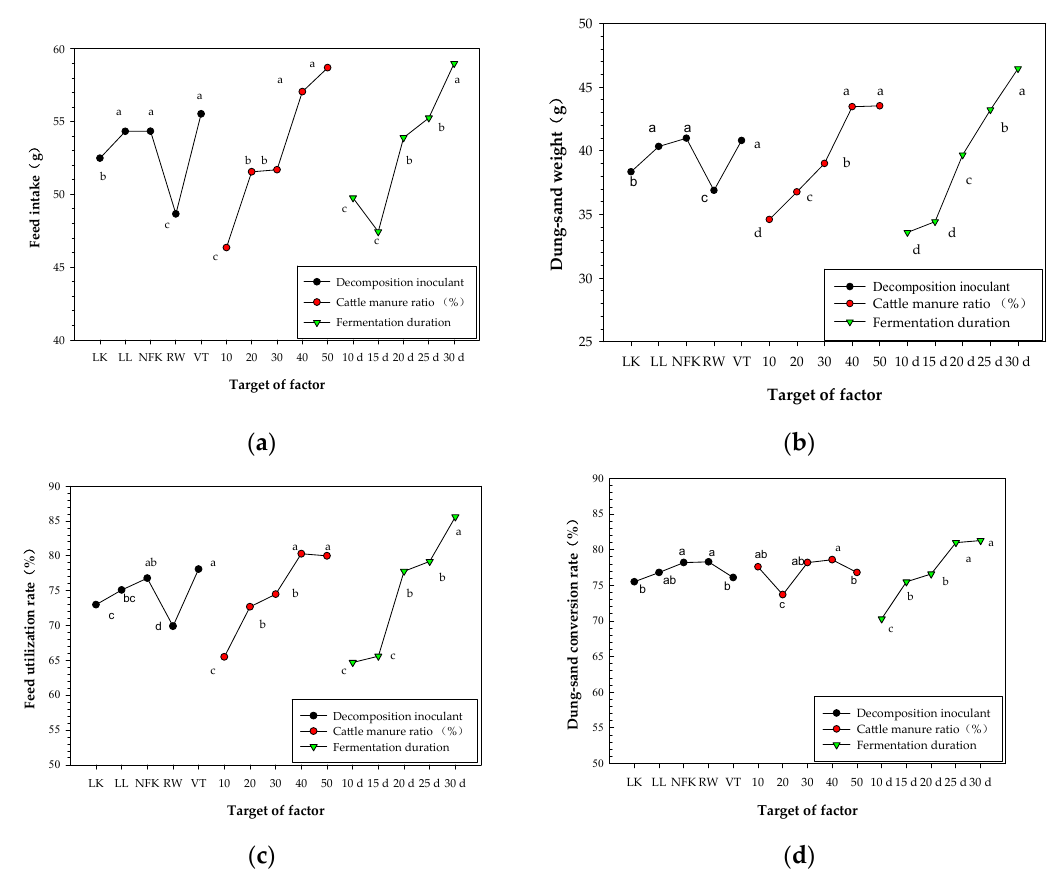
Figure 1. Effect of the decomposition inoculant, cattle manure ratio, and fermentation duration on the feed intake ( a ), dung-sand weight ( b ), feed utilization rate ( c ), and dung-sand conversion rate ( d ) of the 3rd instar larvae of P. brevitarsis . Tukey’s multiple-range tests were used for the analysis. The same factor with a different letter indicated a significant difference ( p < 0.05, n = 20).